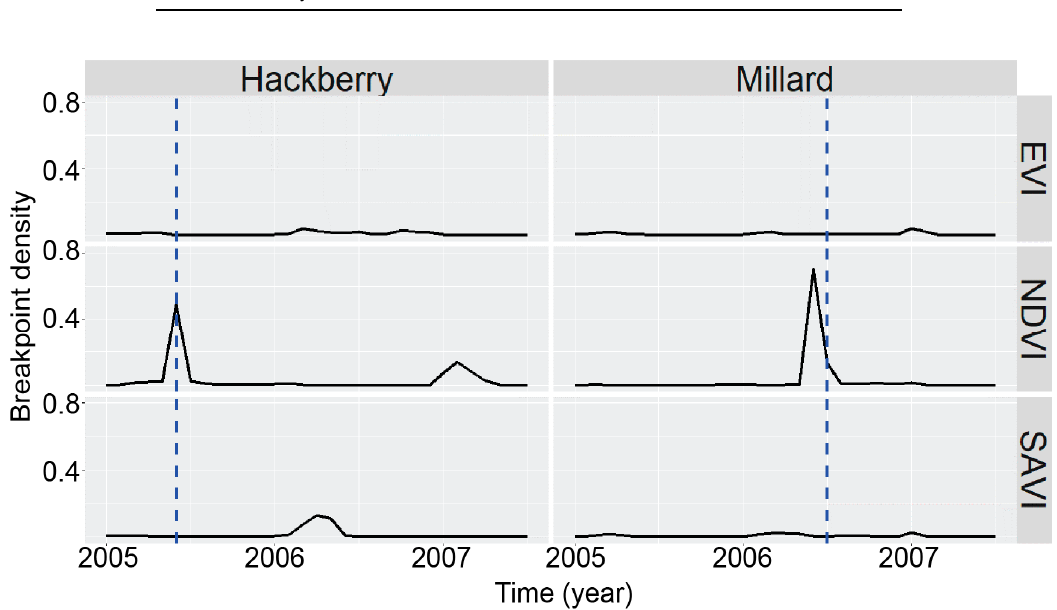
Figure 5. Time series of negative breakpoint density by fire boundary and vegetation indices; vertical bars indicate month of wildfire.